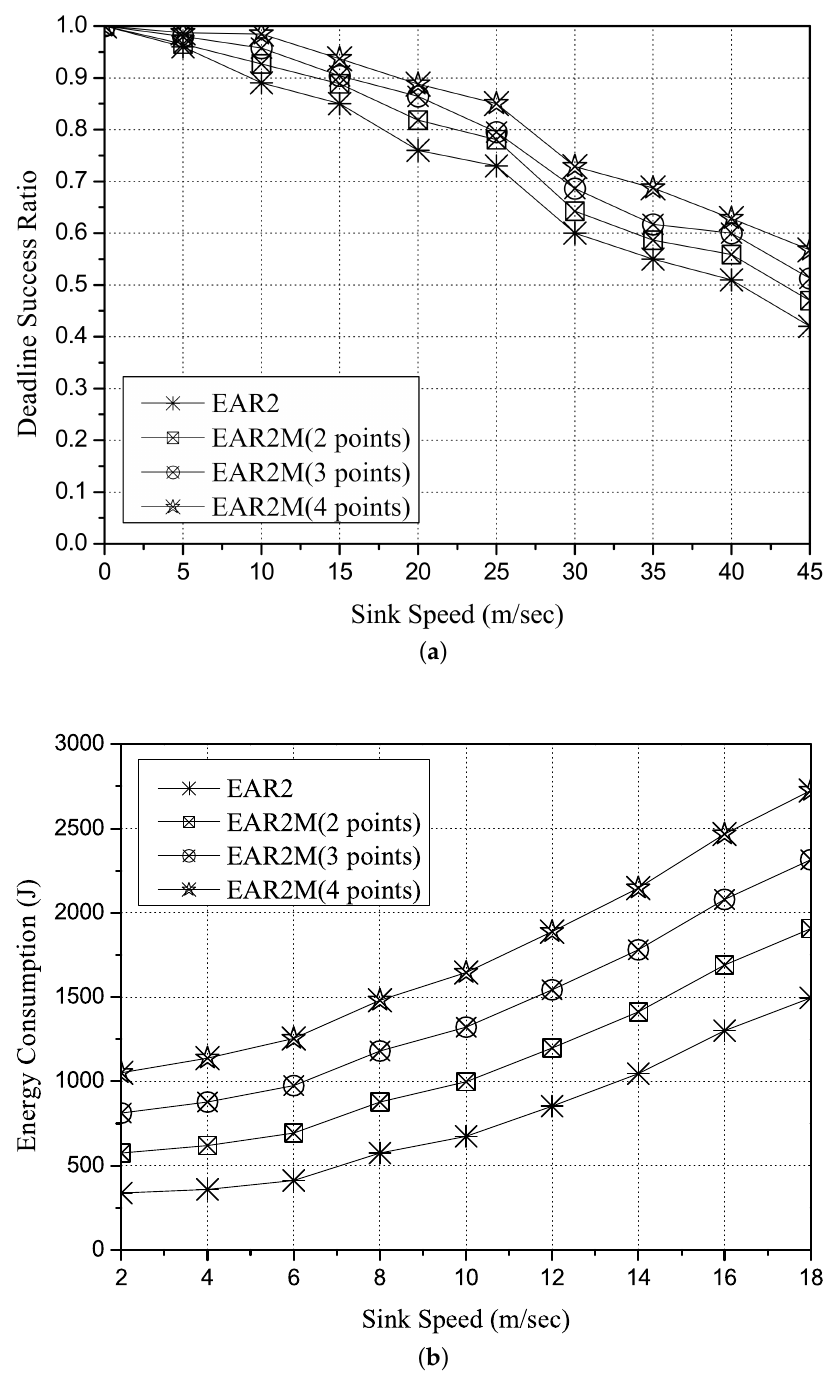
Figure 7. Performance comparison of EAR2 with EAR2M according to sink speed: ( a ) deadline success ratio and ( b ) energy